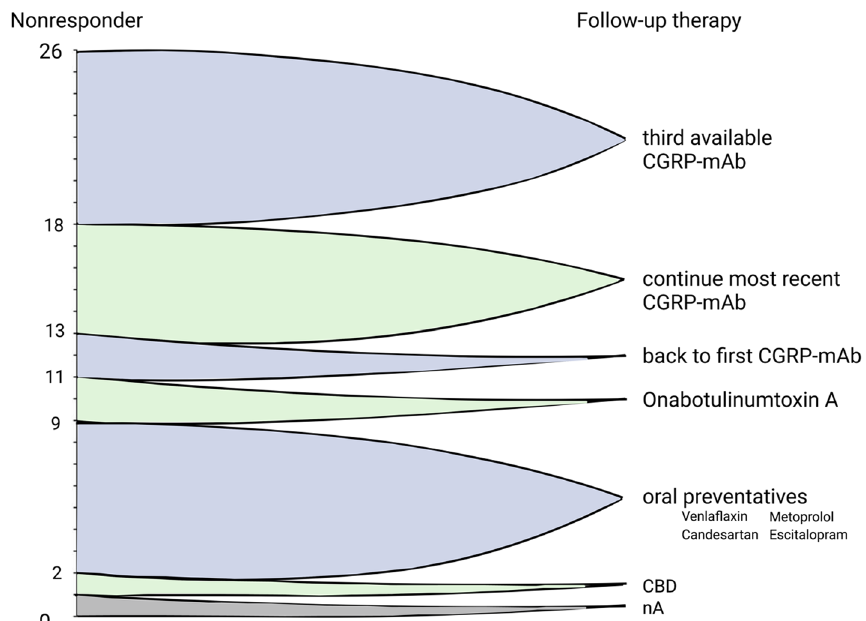
Fig. 2 Follow-up therapy in Non-Responders after unsuccessful treatment with both CGRP mAb and CGRP-R mAb. The left Y-axis shows the number of individual NR ( n 26) and the right Y-axis the follow up therapy performed in these =